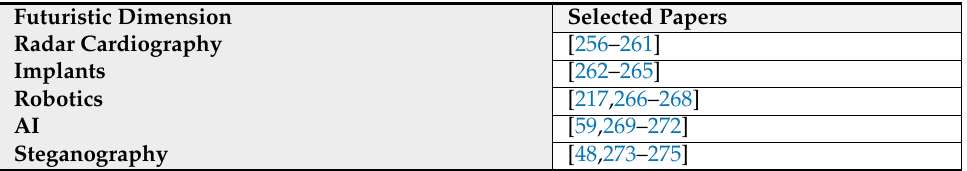
Table 7. Classification of selected futuristic ECG monitoring